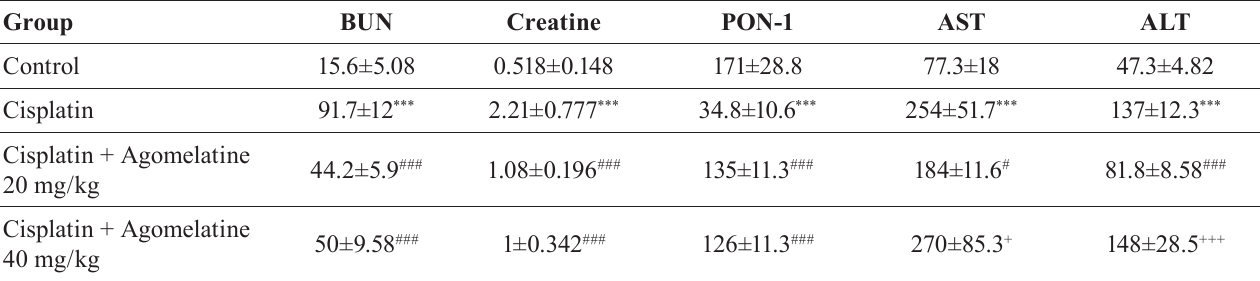
All data expressed as mean±SD. ***p<0.001 versus control group and ### p<0.001, # p<0.05 versus cisplatin group and +++ p<0.001, + p<0.05 versus cisplatin+agomelatine (20 mg/kg)